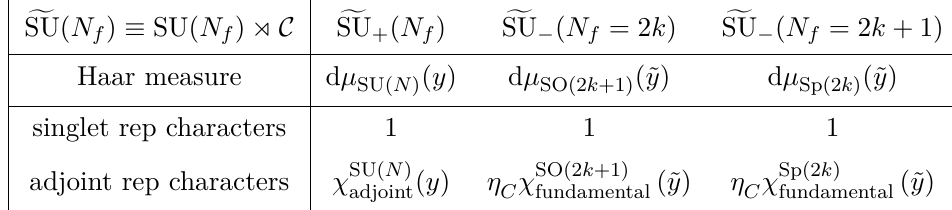
Table 3 . Haar measure and characters for f SU( N f ) ≡ SU( N f ) o C in terms of those of the classical Lie groups. SU( N f ) adjoint representation is self-conjugate under charge conjugation. In this case, there is an overall intrinsic sign choice η = ± for the odd branch character. Our notation Sp(2 k ) C denotes the compact symplectic